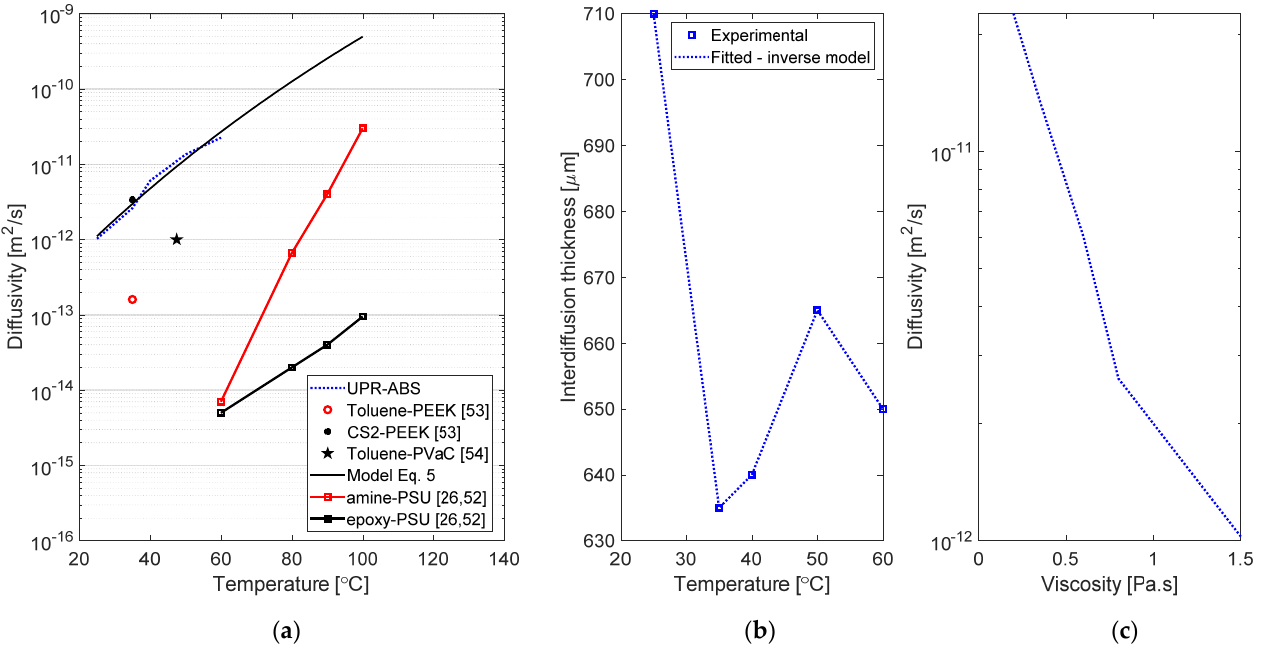
Figure 10. ( a ) Diffusivity vs temperature for UPR-ABS in comparison to material pairs from literature, ( b ) interphase thickness change by temperature through fitted inverse model, and ( c ) viscosity dependency of the diffusivity for UPR-ABS.